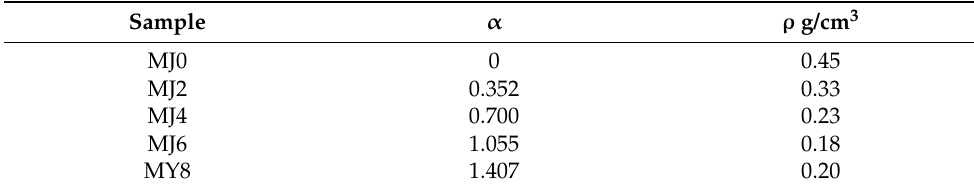
Table 1. Sample notations, trimethyl chlorosilane (TMCS)/tetraethoxysilane (TEOS) molar ratio, and bulk density of the investigated aerogel powders.